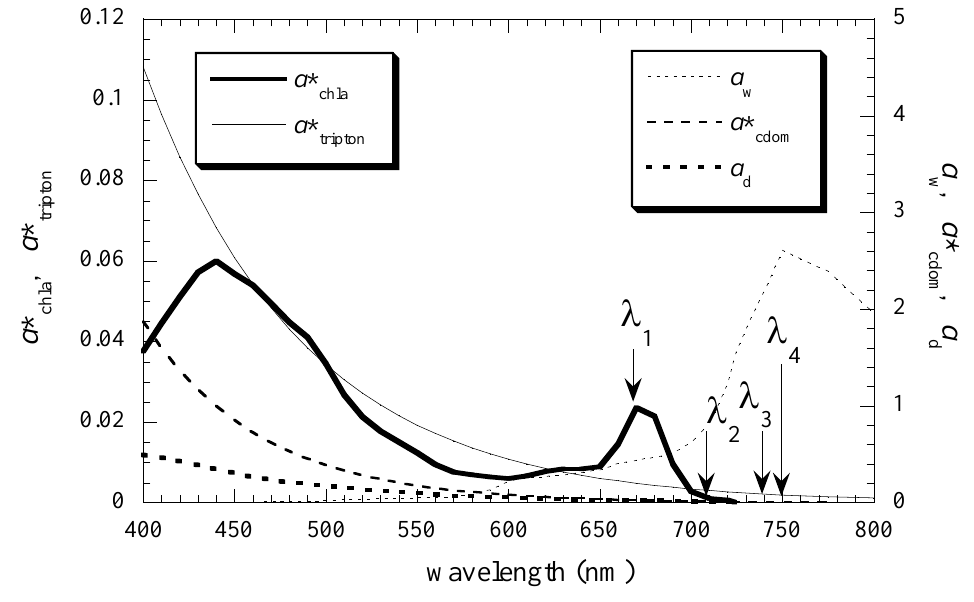
Figure 1. Typical absorption from Yang et al. [21] for a * chla , a * tripton , a w , a * cdom . The a d is from Kobayashi and Higa (private note) measured in Tokyo Bay.